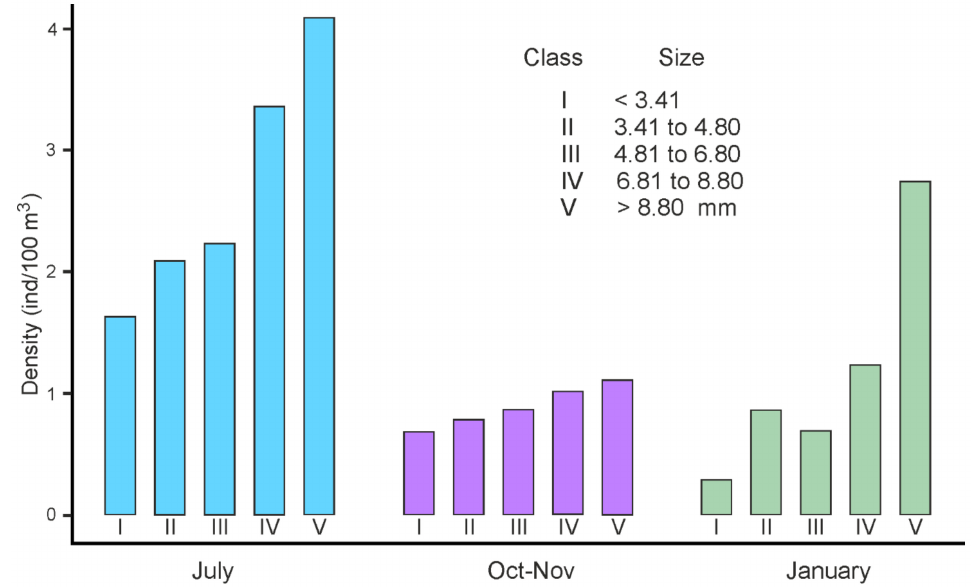
Figure 10. Size structure of the Lucifer typus population throughout three sampling seasons.